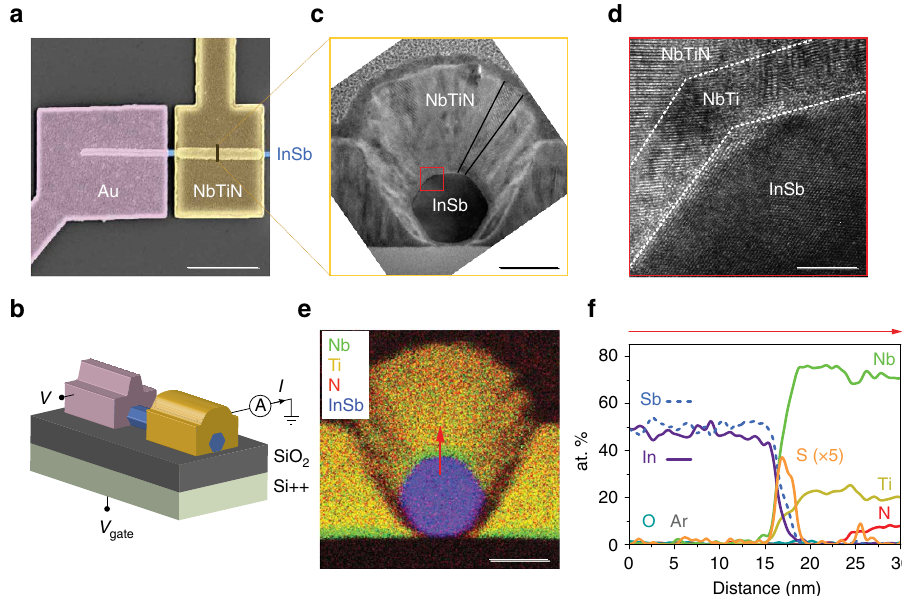
Figure 1 | TEM analysis of a typical device. ( a ) Top-view, false-colour electron micrograph of device A. Scale bar, 1 m m. Normal metal contact is Cr/Au (10nm/125nm) and superconducting contact is NbTi/NbTiN (5nm/85nm). Contact spacing is B 100nm. ( b ) Device schematic and measurement setup. ( c ) Low-magnification high-resolution TEM (HRTEM) cross-sectional image from the device (see Methods). Scale bar, 50nm. The cut was performed perpendicular to the nanowire axis, indicated by the dark bar in a . InSb nanowire exhibits a hexagonal cross-section surrounded by {220} planes. The NbTiN on the pre-layer NbTi crystallizes as cone-like elongated grains, indicated by the thin black lines. Corresponding fast Fourier transform confirms the polycrystalline character of the NbTiN region (Supplementary Fig. 2b). ( d ) HRTEM image near the interface (red square in c ) shows that our cleaning procedure only minimally etches the wire and the InSb crystalline properties are preserved after the deposition. Scale bar, 5nm. ( e ) Energy-dispersive X -ray (EDX) compositional map of the device cross-section. Scale bar, 50nm. ( f ) EDX line scan taken across the interface as indicated by the red arrow in e . The sulfur content is multiplied by 5 for clarity. The system is oxygen and argon free (contact deposition is performed in an Ar plasma